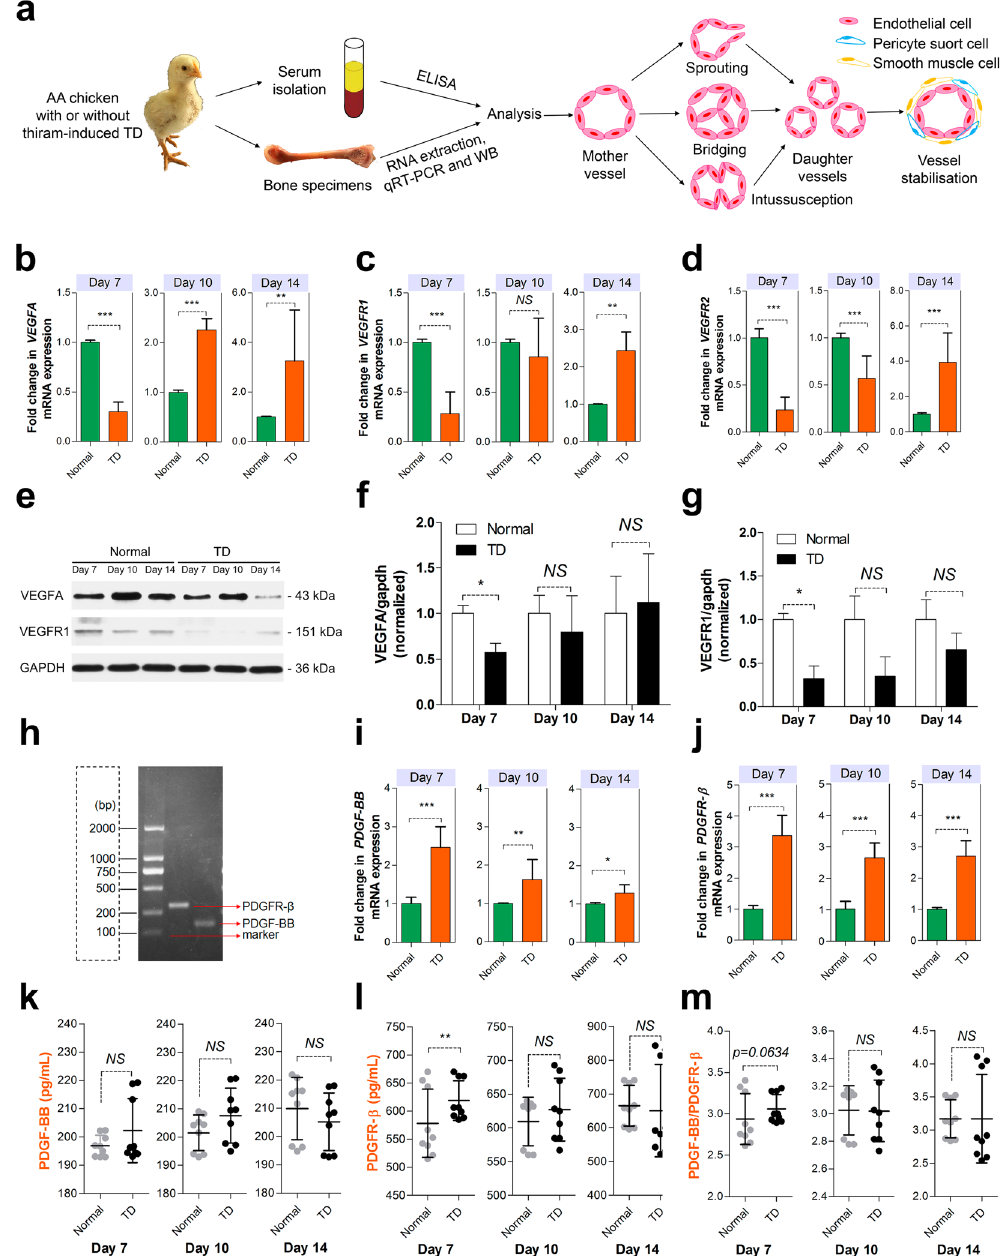
Figure 4. Inhibition of tibial angiogenesis in TD chickens. ( a ) A schematic diagram illustrating the experimental design and procedure of angiogenesis. Serum and bone specimens were collected from normal and TD chickens at 7, 10 and 14 days old, respectively. ( b–d ) qRT-PCR analysis of VEGFA, VEGFR1 and VEGFR2 expression (normalized to GAPDH) in proximal TGPs sorted from normal and TD chickens at 7, 10 and 14 days, respectively. Data represent means ± s.e.m. (n = 3 biological replicates). ** p < 0.01, *** p < 0.001, two-tailed unpaired t -test. NS, not significant. ( e–g ) Western blot analysis ( e ) and the quantitation ( f , g ) of the relative levels of VEGFA and VEGFR1 protein expression in proximal TGPs derived from normal and TD chickens at 7, 10 and 14 days, respectively. (n = 3 in each group from three independent experiments). Data represent means ± s.e.m. * p < 0.05, two-tailed unpaired t -test. NS, not significant. ( h ) The gel electrophoresis diagram of the PDGF-BB and PDGFR- β gene. ( i , j ) qRT-PCR analysis of PDGF-BB and PDGFR- β expression levels (normalized to GAPDH) in proximal TGPs sorted from normal and TD chickens at 7, 10 and 14 days, respectively. Data represent means ± s.e.m. (n = 3 biological replicates). *** p < 0.001, two-tailed unpaired t -test. NS, not significant. ( k–m ) PDGF-BB and PDGFR- β concentrations assessed by serum ELISAs and PDGF-BB/PDGFR- β ratios were also determined. (n = 9 in each group from three independent experiments, 3 technical replicates per experiment). Data represent means ± s.d. ** p < 0.01, two-tailed unpaired t -test. NS, not